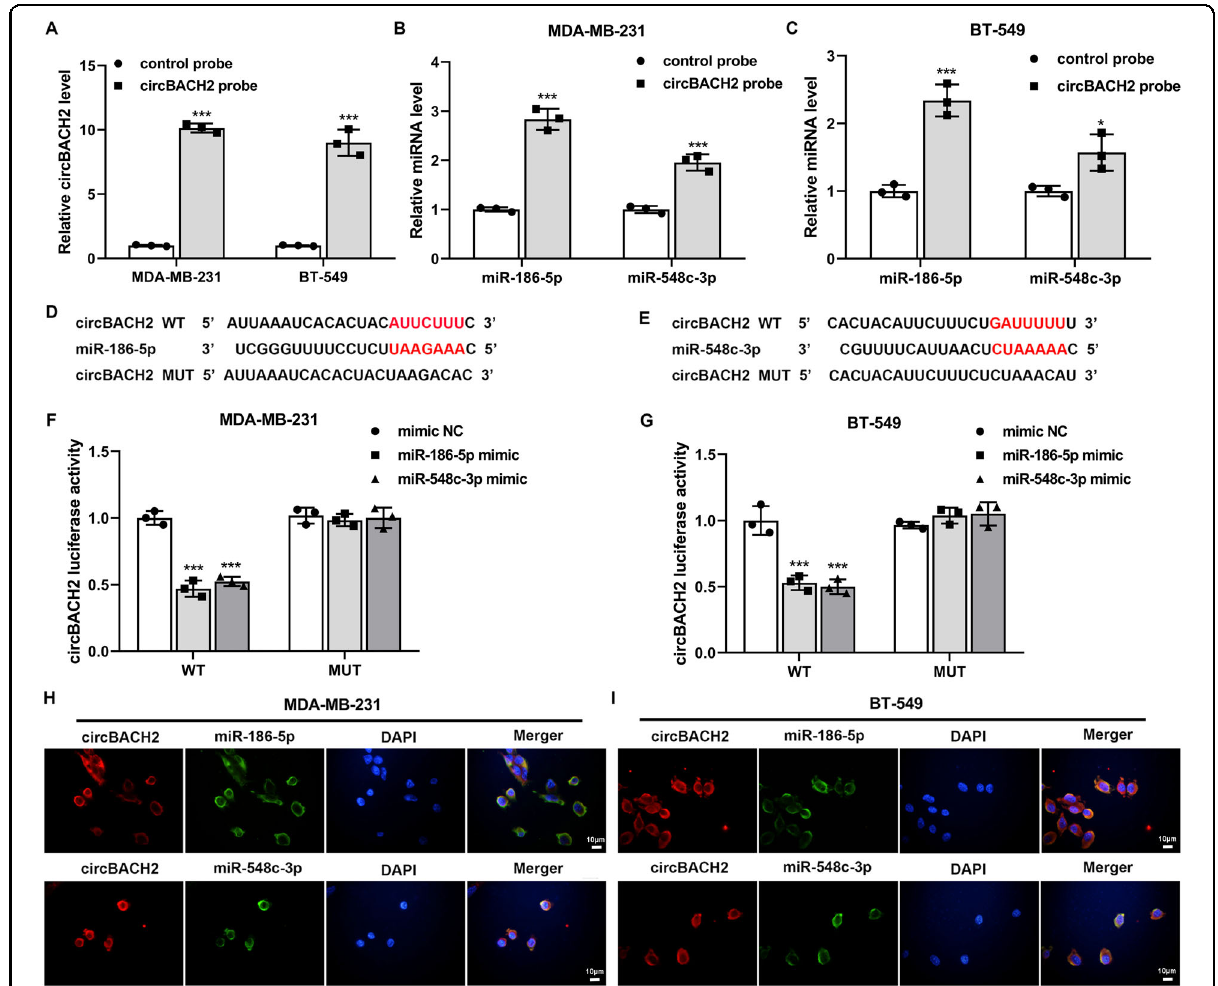
Fig. 4 circBACH2 functioned as a sponge for miR-186-5p and miR-548c-3p in TNBC cell lines. A – C RNA pull-down assay was performed in MDA-MB-231 and BT-549 cells using a biotin-labeled circBACH2 probe, following by qRT-PCR. The control probe was used as a negative control. D , E The predicted binding sites between circBACH2 and miR-186-5p/miR-548c-3p. F , G The luciferase reporter assay was performed in MDA-MB-231 and BT-549 cells that were co-transfected with circBACH2 wild type (WT)/mutant type (MUT) luciferase vector and miR-186-5p mimic/miR-548c-3p mimic/ mimic NC. H – I Fluorescence in situ hybridization (FISH) was executed to con fi rm the location of circBACH2 (red) and miR-186-5p/miR-548c-3p (green) in MDA-MB-231 and BT-549 cells. Nuclei were stained blue with DAPI. Scale bar = 10 µm. * P < 0.05, *** P < 0.001 vs control probe or mimic